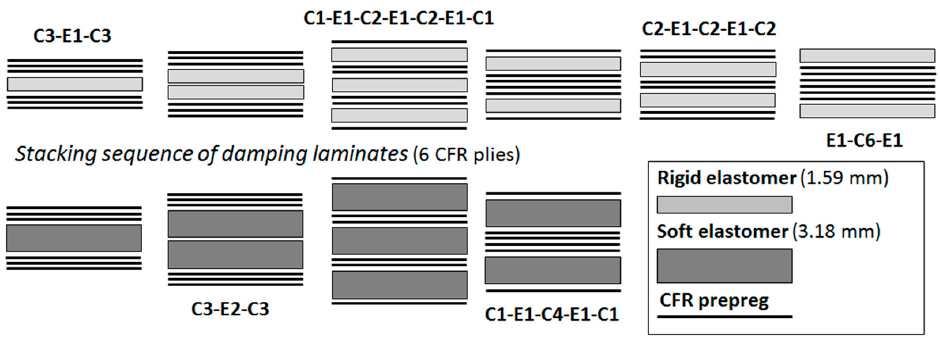
Figure 1. Experimental methodology.